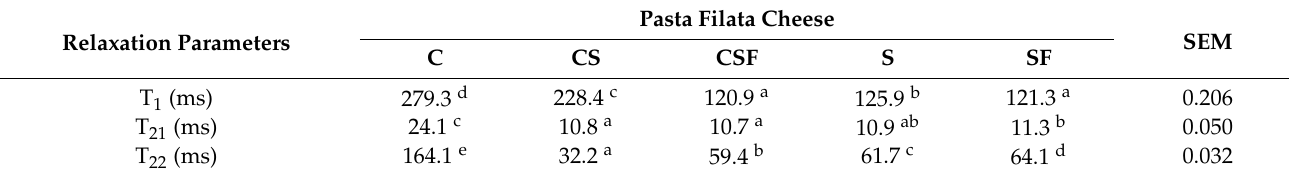
a–e Means within a row with different superscripts differ ( p < 0.05); SEM: standard error of the mean ( n = 5); C: from cow’s milk; CS: from cow’s and unfrozen sheep’s milk in proportion 70:30; CSF: from cow’s and frozen sheep’s milk in proportion 70:30; S: from unfrozen sheep’s milk; SF: from frozen sheep’s